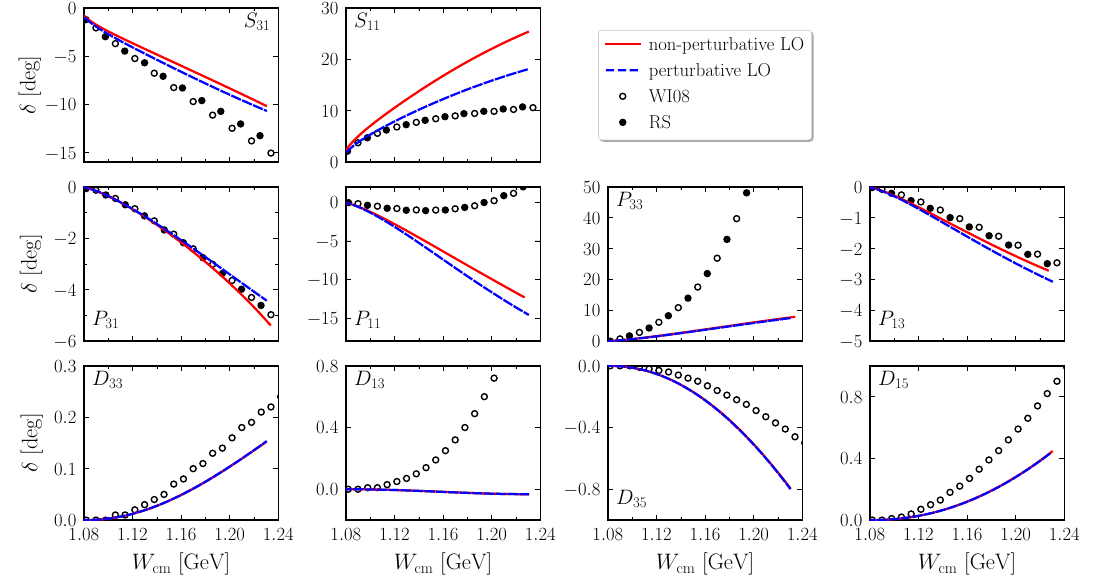
Fig. 2 Pion-nucleon scattering phase shifts in standard partial-wave notation. Blue (dashed) lines are the LO perturbative results (tree-order result),red(solid)linesrepresenttheresultsoftheresummedLOpoten-